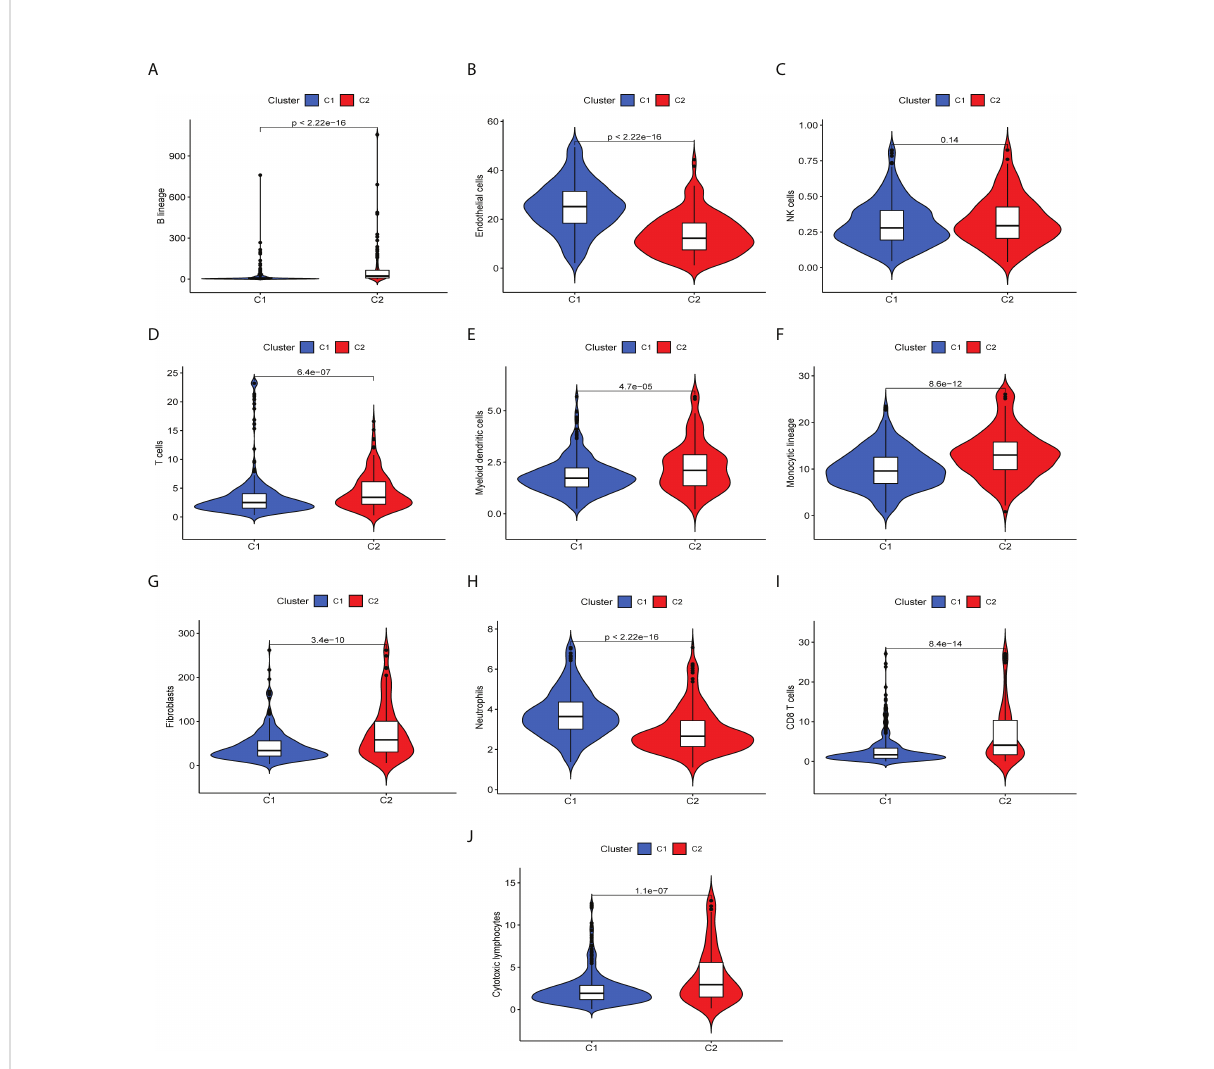
FIGURE 2 Differences of immune in fi ltrating cells in the immune microenvironment of two ccRCC molecular subtypes. (A-I) Levels of immune cell in fi ltration in the two subtypes. (A) B lineage, (B) endothelial cells, (C) NK cells, (D) T cells, (E) myeloid cells, (F) monocytic lineage, (G) fi broblasts, (H) neutrophils, (I) CD 8+T cells, (J) cytotoxic